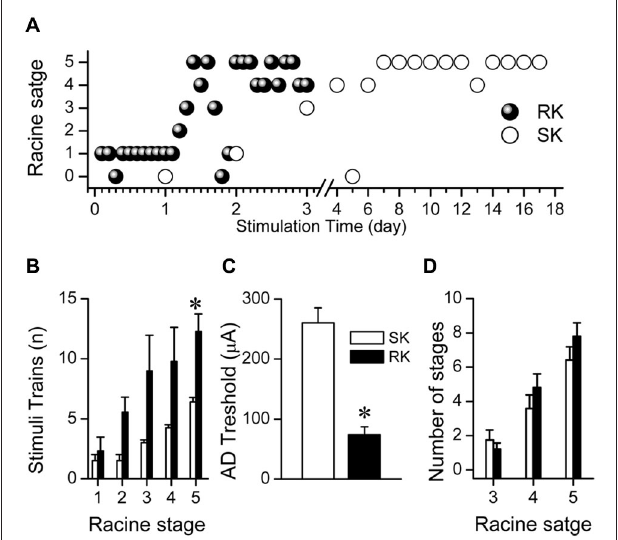
FIGURE 2 | RK rats reach kindled state faster than SK rats. (A) Representative progression of Racine stages in two rats subjected to RK or SK protocols. (B) Number of trains required to reach every Racine stage for each protocol. (C) Average AD thresholds for each protocol. (D) Average number of total amount for Racine stages 3, 4 and 5, induced by both protocols ( t -test, * p < 0.05, n = 9 in RK and n = 5 in